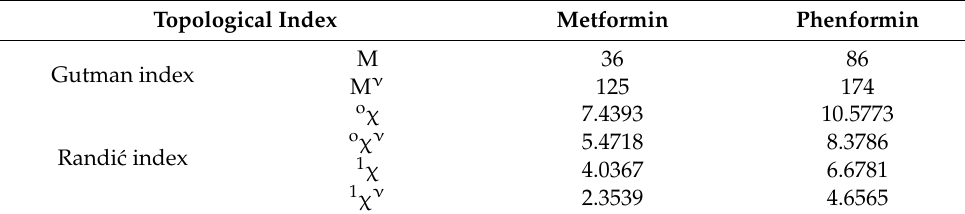
Table 3. Topological indices calculated for the studied compounds. Topological Index Metformin Phenformin Gutman